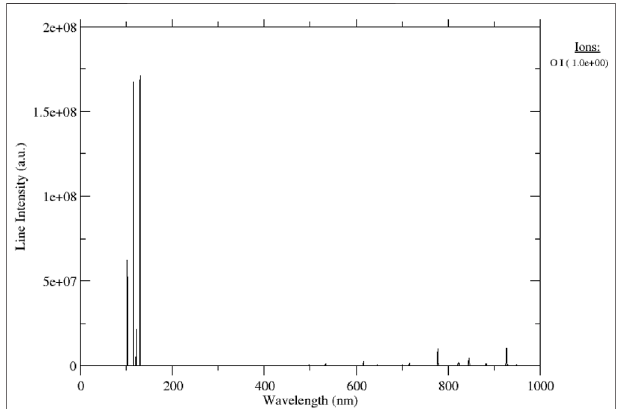
FIGURE 1 | The spectrum of oxygen plasma with electron temperature 3 eV and density 1 × 10 16 m − 3 [23].